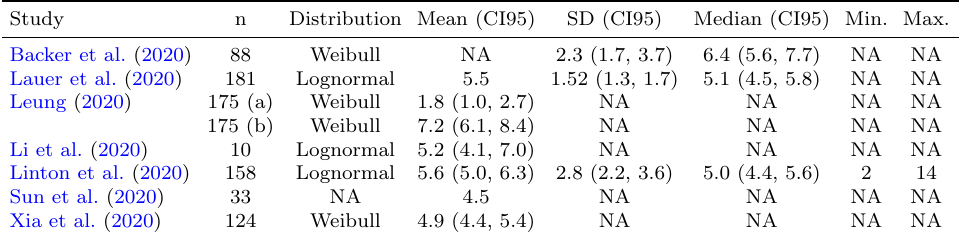
Table 2: Studys estimating the incubation period of